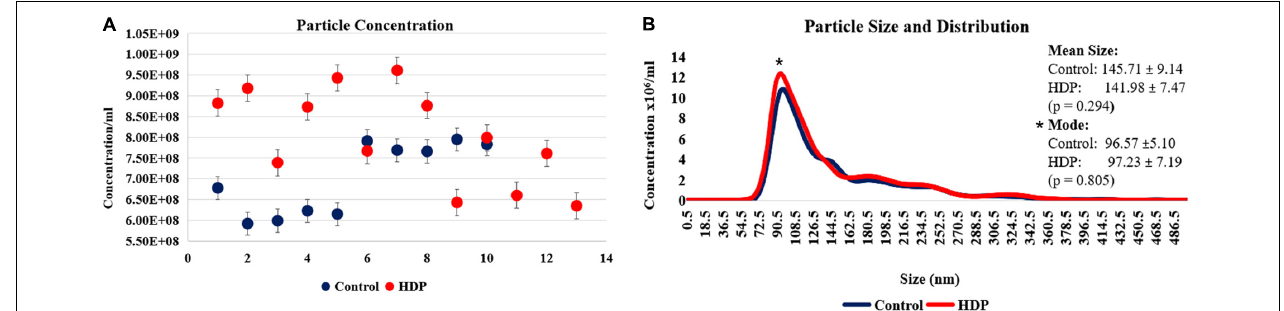
FIGURE 1 | Nanoparticle tracking analysis of enriched plasma. (A) Overall nanoparticle tracking analysis (NTA) of enriched plasma shows an increase in particle concentration on HDP (8.04 ± 1.14 × 10 8 nm; n = 13) when compared with controls (7.01 ± 0.87 × 10 8 nm; n = 10; p = 0.027). (B) Particle size distribution revels no significant differences on Mean and Mode particle concentration on HDP and control (Mean of 141.98 ± 7.47 nm, and 145.71 ± 9.14 nm; Mode of 97.23 ± 7.19 nm, and 96.57 ± 5.10 nm, respectively; p = 0.805).